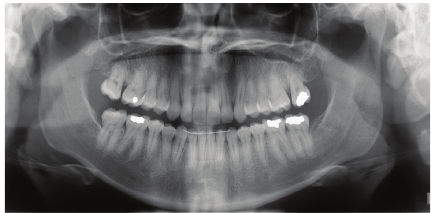
Figure 11: Final panoramic radiograph.